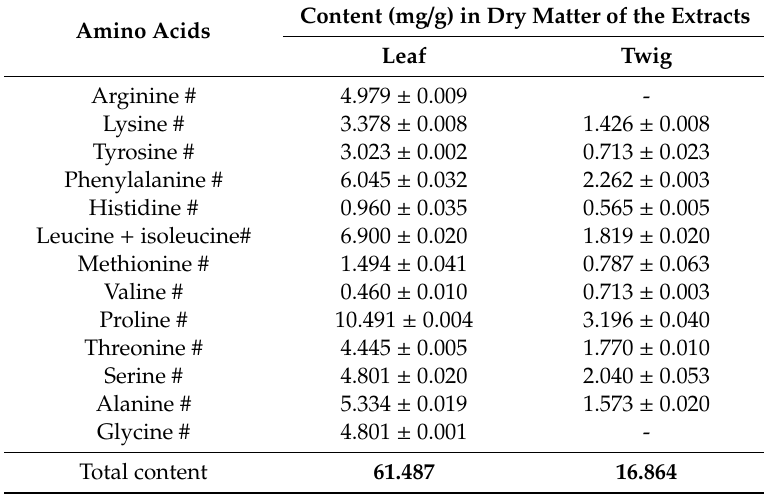
Table 3. The content of amino acids in dried extracts from twigs and leaves of R. canina